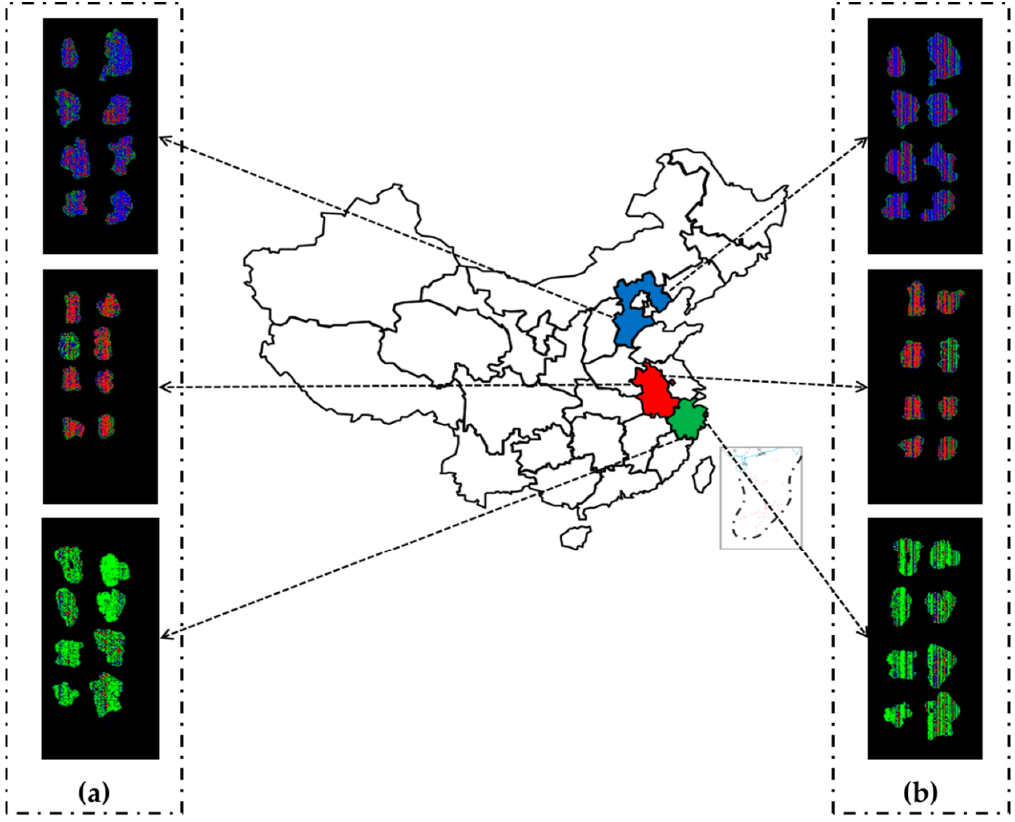
Figure 8. Classification maps by PLS-DA models in the VNIR range (435–898 nm) ( a ) and the SWIR range (900–1601 nm) ( b ) based on the prediction set. The red, green and blue represent Anhui, Zhejiang, and Hebei, respectively. The non-uniform distribution resulted from the categories of pixels not being completely